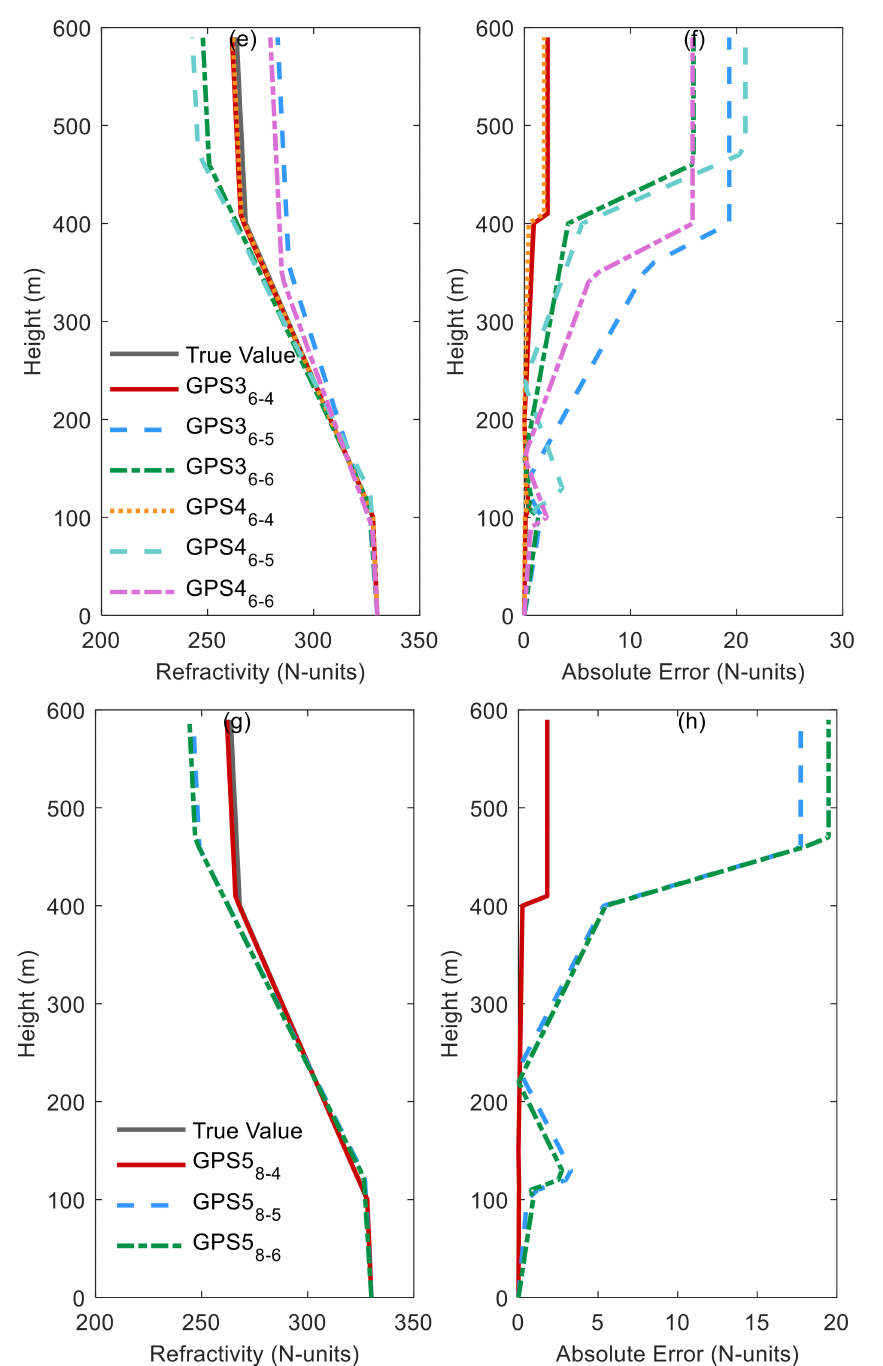
Figure 3. Comparison of simulated and retrieved profiles by EN-MOEA / ACD-NS in the problems for GPS1, GPS2, GPS3, GPS4, and GPS5, respectively. ( a ) is the simulated and retrieved profiles for GPS1; ( b ) is the absolute error of retrieved profiles for GPS1; ( c ) is the simulated and retrieved profiles for GPS2; ( d ) is the absolute error of retrieved profiles for GPS2; ( e ) is the simulated and retrieved profiles for GPS3 and GPS4; ( f ) is the absolute error of retrieved profiles for GPS3 and GPS4; ( g ) is the simulated and retrieved profiles for GPS5; ( h ) is the absolute error of retrieved profiles for